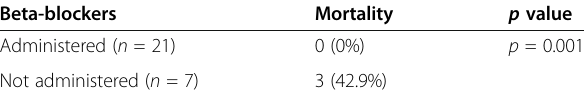
Table 5 Relation of use of beta-blocker and mortality in gastric pull-up patients Beta-blockers